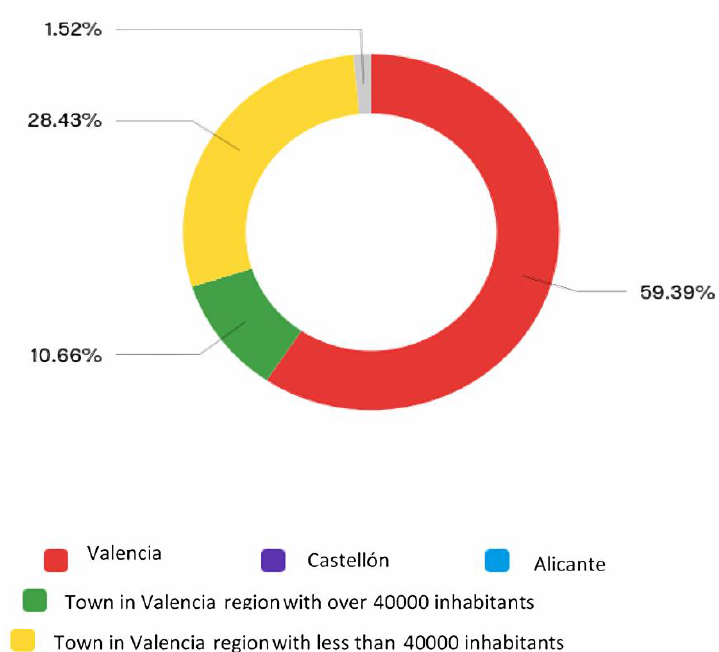
Figure 2. Geographical location of the sample in Spain.